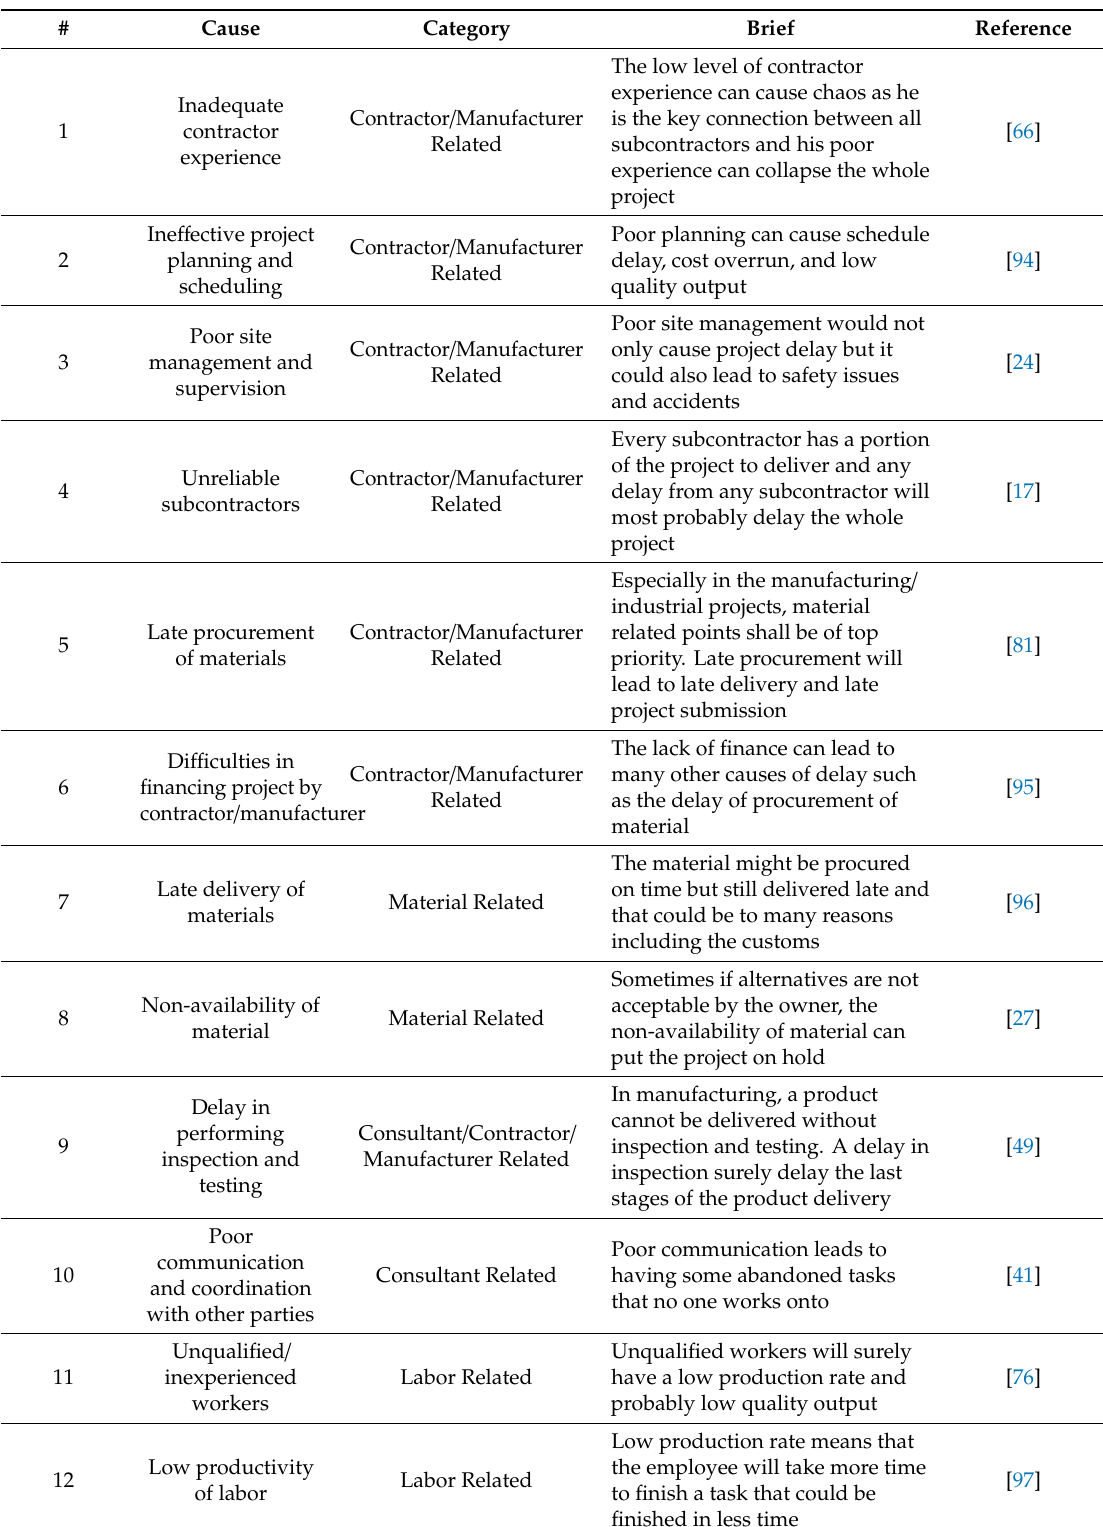
Table 1. The identified causes of